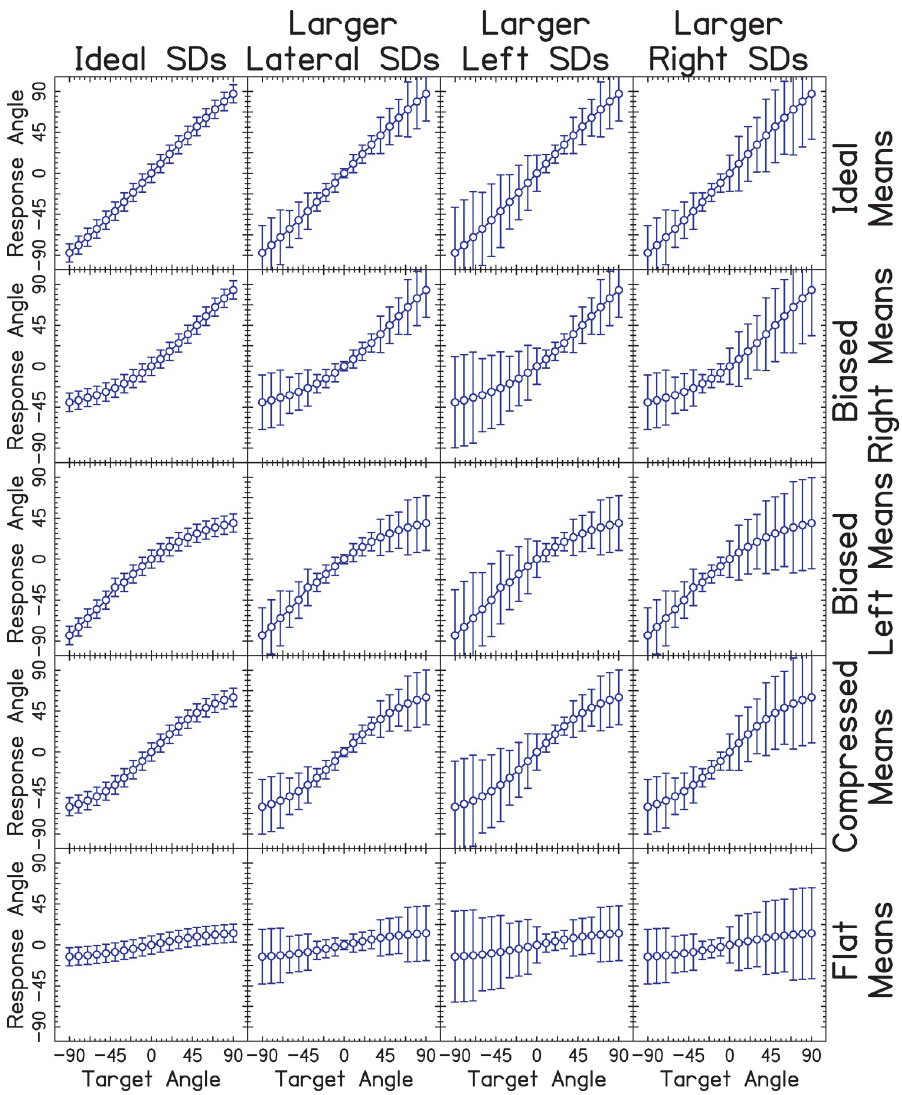
Fig 6. Categories of localization performance. Plotted as in Fig 3, except that each panel corresponds to a different category of localization performance as defined by experimenters. Each row and column represent a different distribution of mean and standard deviation (SD) of response angles,